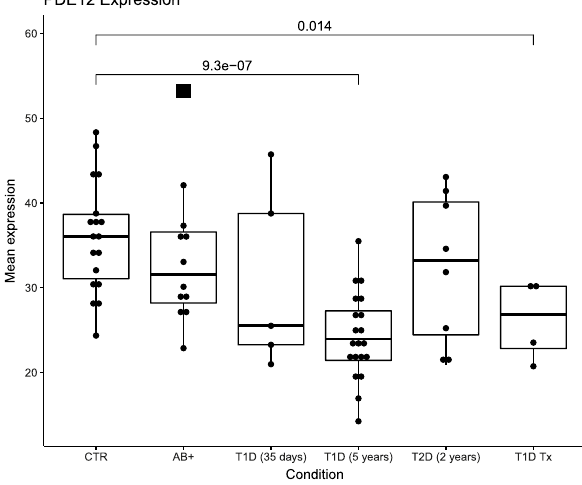
Figure 1. Phosphodiesterase 12 ( PDE12 ) gene expression. CTR: non-diabetic controls ( n = 18); AB + : non- diabetic autoimmune antibody-positive donors ( n = 12); T1D (median disease duration, 35 days): donors with newly diagnosed type 1 diabetes ( n = 5); T1D (median 5 years): donors with recently diagnosed type 1 diabetes ( n = 20); T2D (median 2 years): donors with type 2 diabetes ( n = 8); T1D Tx: biopsies from donors with recurrent T1D ( n = 4). Boxes indicate 25% and 75% quartiles, whiskers 1.5 × interquartile ranges, and squares mark outliers. The p -values shown were calculated using unpaired two-sided t -tests relative to CTR. Test statistics for CTR vs T1D (5 years): t-statistic 6.054, 95%CI 7.74;15.59, degrees of freedom 31.997, mean of CTR 35.95, mean of T1D (5 years) 24.29. Test statistics for CTR vs T1D Tx: t-statistic 3.43, degrees of freedom 5.87, 95%CI 2.78;16.81, mean of T1D Tx